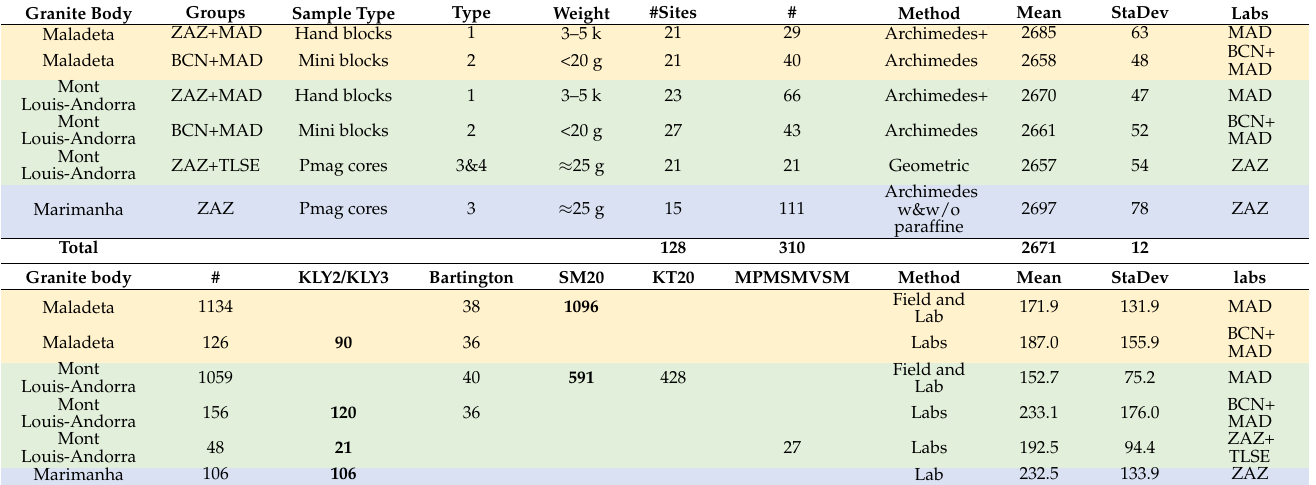
Table 2. Summary of new density and susceptibility measurements (depending upon the sample type) carried out in this paper, specifying laboratory procedures, instrumentation, mean values and standard deviation per granite pluton (see body text for further explanations). Groups/Labs: MAD: Madrid, BCN: Barcelona, ZAZ: Zaragoza, TLSE: Toulouse. Density measurements in kg/m 3 and susceptibility in µ